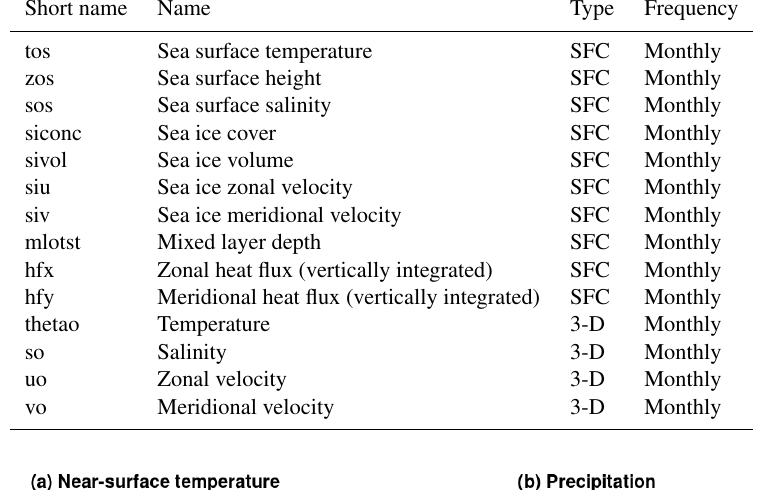
Table 3. As Table 1 but for saved ocean variables. All ocean variables are saved as monthly means. Three-dimensional variables are provided on the native 75 levels of the ORCA1L75 grid.